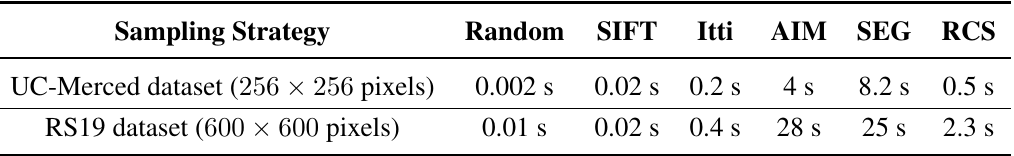
Table 2. Running time for producing response maps for a sample image using different sampling strategies on two testing